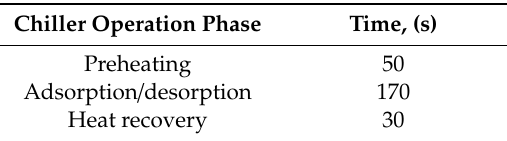
Table 3. The time of each